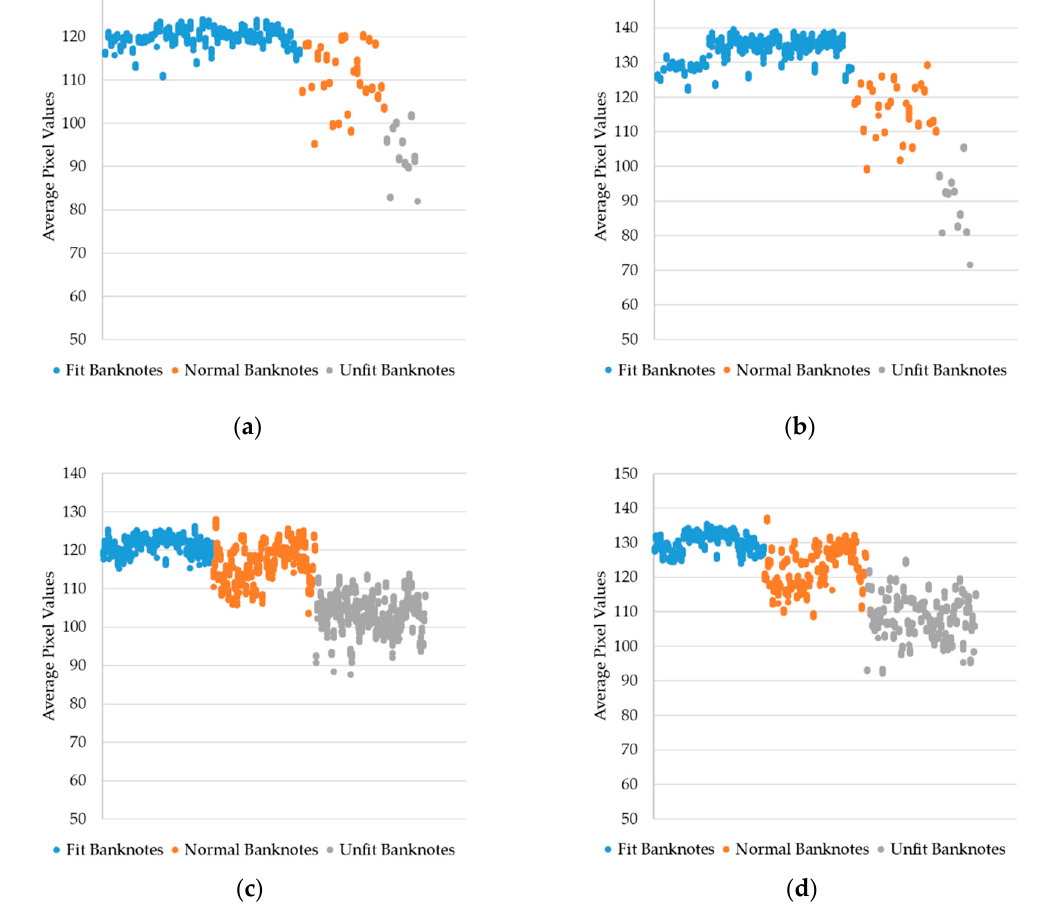
Figure 6. Comparison of average pixel values of VR banknote images from ( a ) INR10 front forward direction (INR10A); ( b ) back side of banknotes in ( a ) (INR10C); ( c ) KRW5000 front backward direction (KRW5000B); and ( d ) back side of banknotes in ( c ) (KRW5000D).